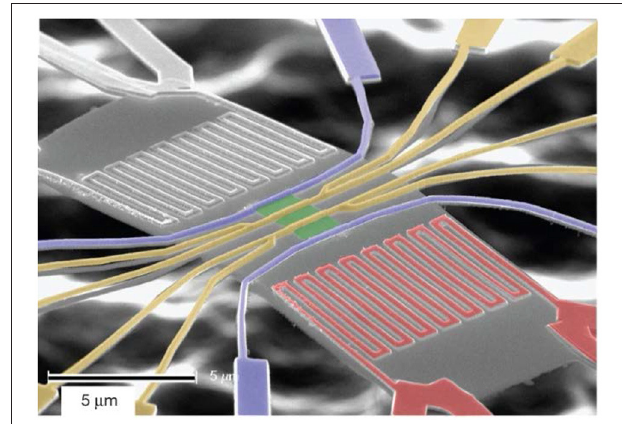
FIGURE 12 | Typical 4-point probe method for TE measurement.Reprint from Boukai et al.